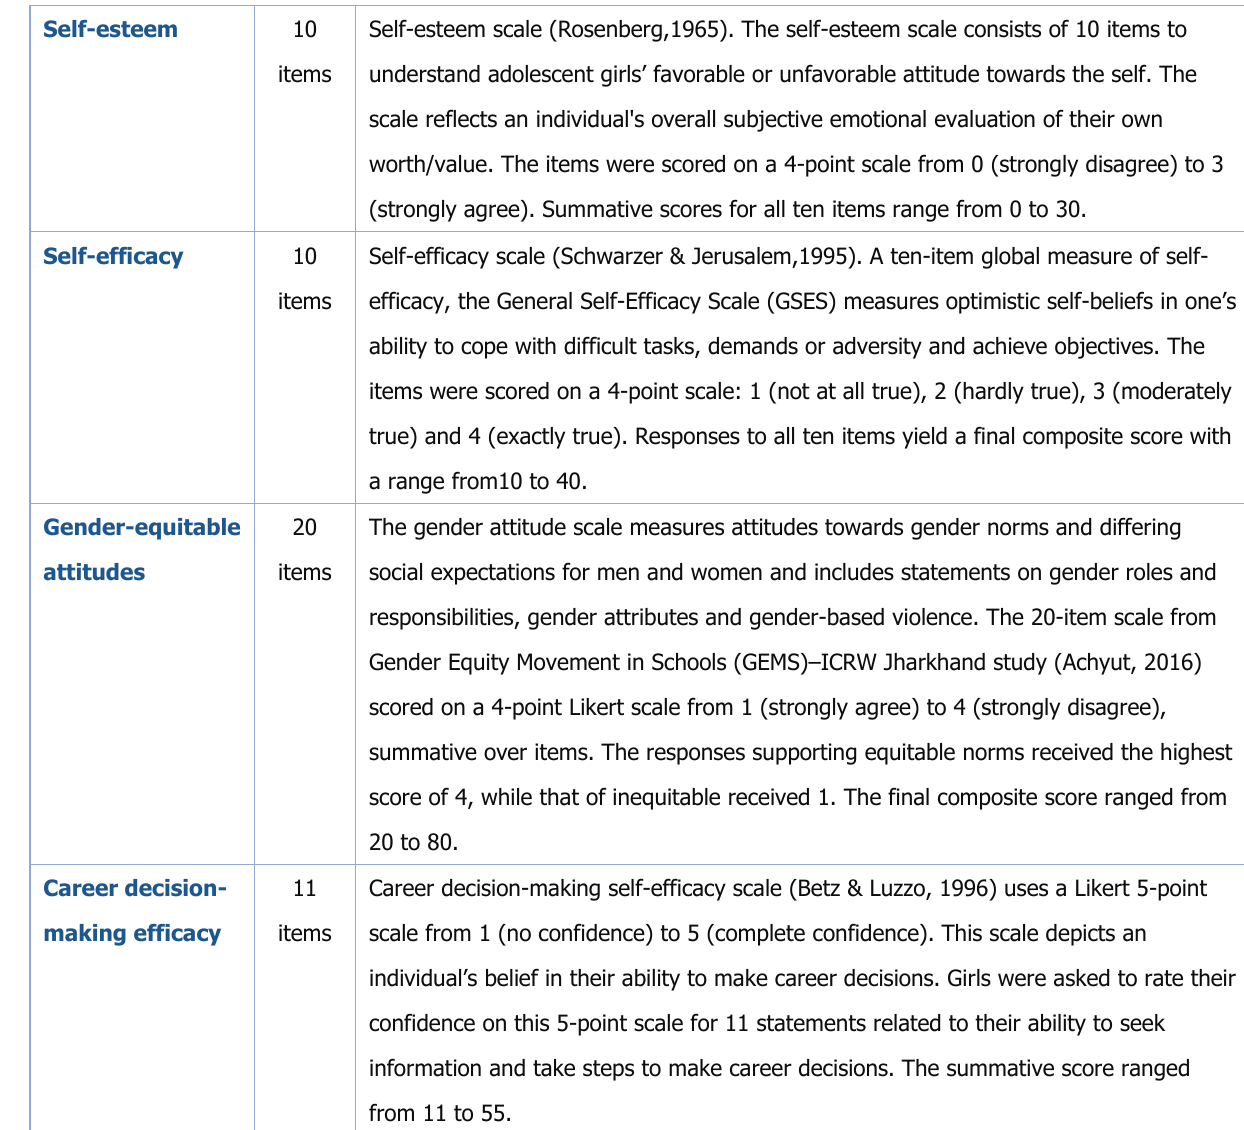
Table 2. Operational Definitions of Empowerment and Employability Indicators